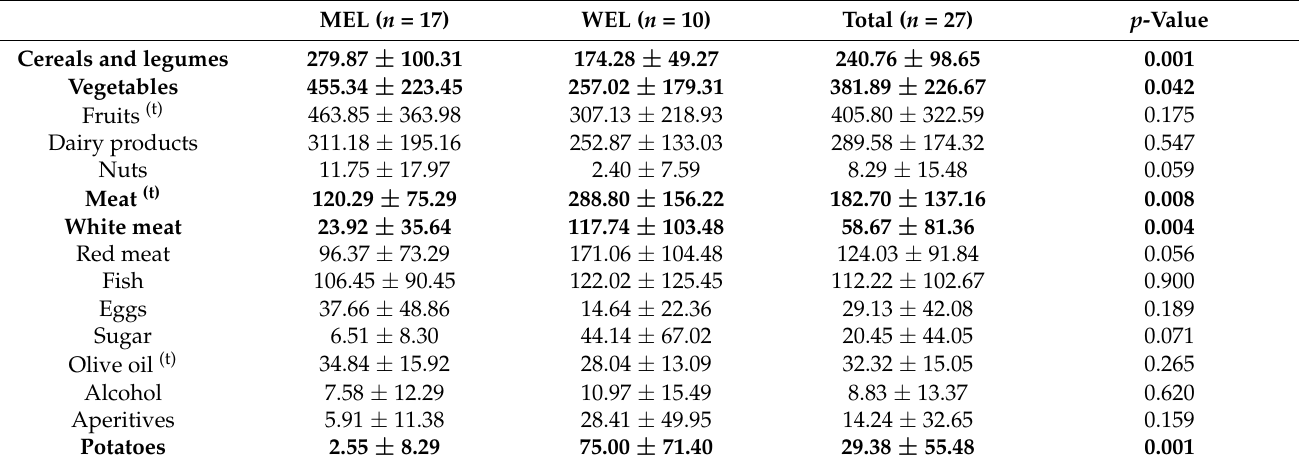
Table 2. Intake (g/day) of each food group per dietary pattern.